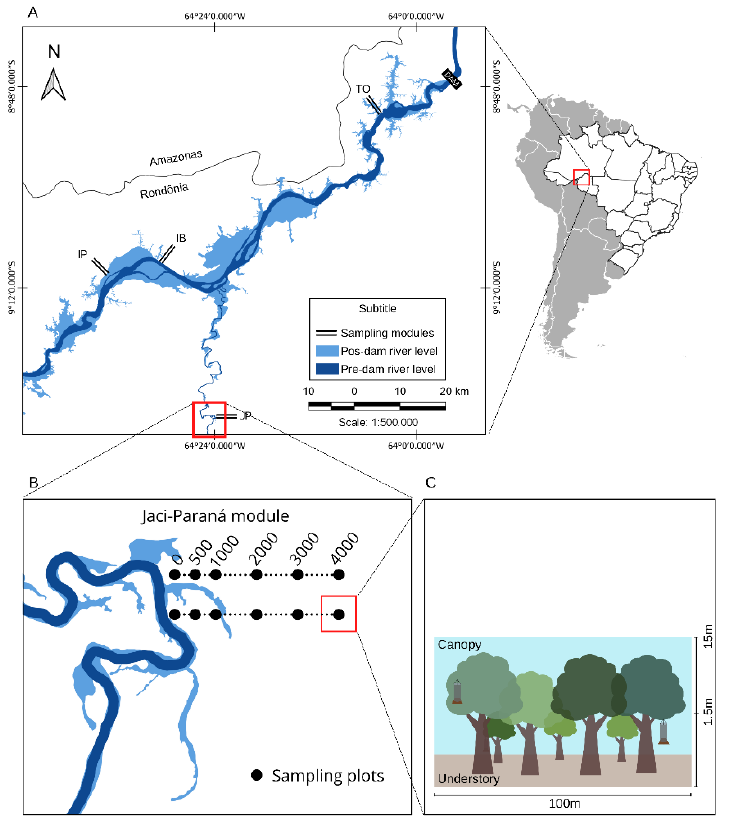
Figure 1. Location of the study area showing the four sampling sites along the Madeira River, in southwestern Amazonia, Brazil. ( A ) Teotônio (TO), Ilha de Búfalos (IB), Ilha das Pedras (IP), Jaci Paraná (JP), ( B ) A sampling site with two 5-km transects and six plots (black circles) at 0, 500, 1000, 2000, 3000 and 4000 m from the bank of the Madeira River ( C ) A plot with a trap in the understory and in the canopy 100 m apart.